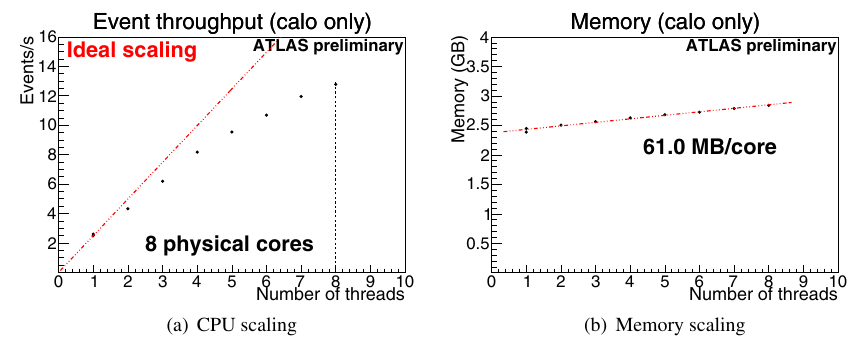
Figure 2. Scaling of CPU time and memory required versus number of threads for a calorimeter-only reconstruction job with output disabled reading simulated data. Tested on an Intel Xeon X5560 system with eight physical